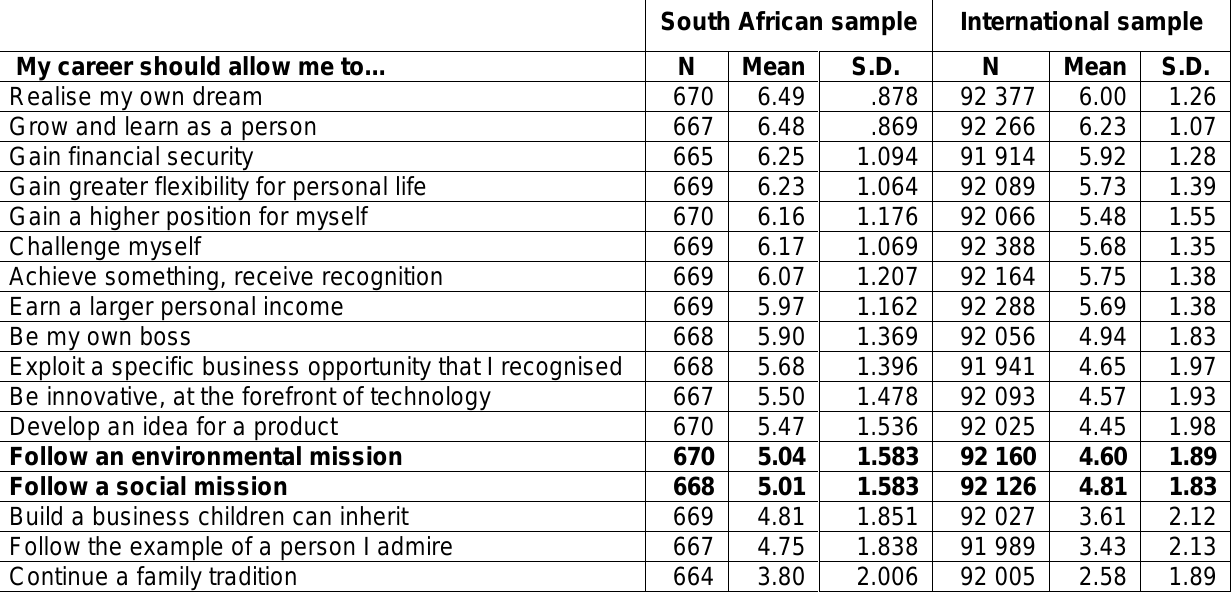
South African sample International